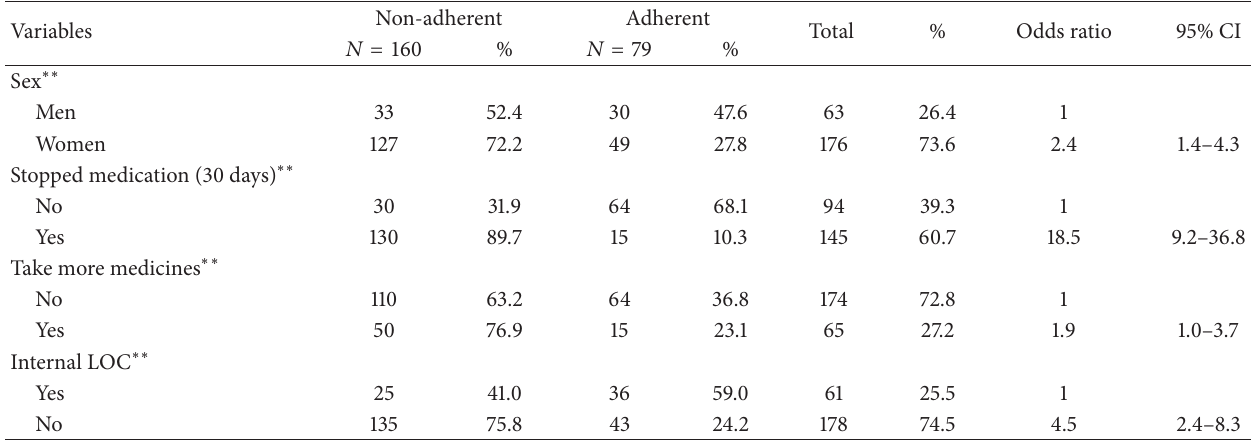
Table 9: Factors associated with poor adherence: results of bivariate